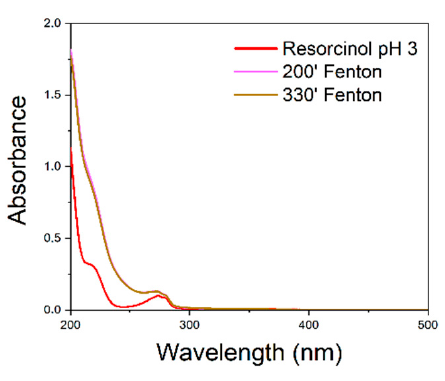
Figure 4. UV–vis spectra of Fenton-processed resorcinol solution using the unregenerated catalyst for the second time. UV–vis spectra recorded after 200 and 330 min overlap.